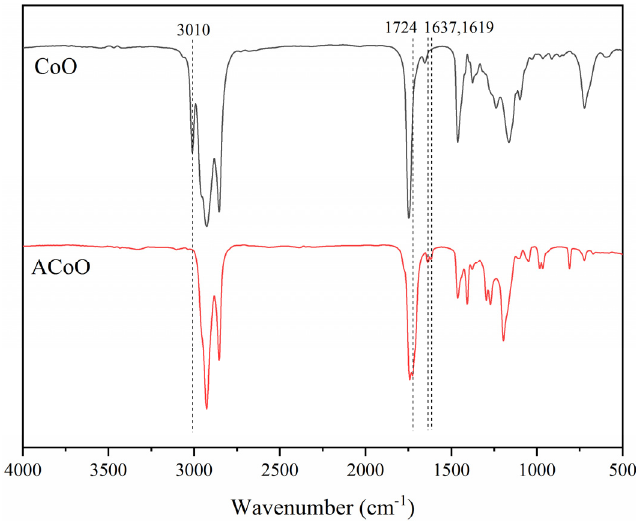
Figure 1. Fourier transform infrared (FT-IR) spectra of corn oil (CoO) and corn oil-based acrylate prepolymer(ACoO).